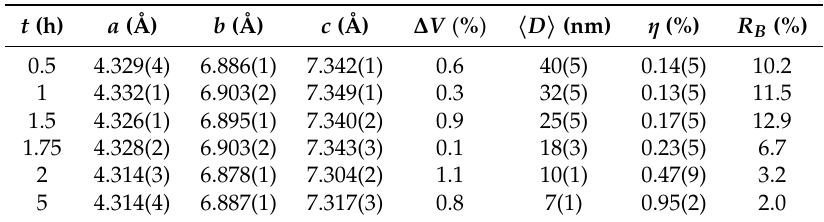
Table 1. Orthorhombic mean lattice parameters ( a , b and c ); relative change in the unit size volume cell with respect to the unit cell in bulk alloy ( ∆ V ), size (cid:104) D (cid:105) , microstrain η and Bragg factor R B of nanoparticles at different milling times ( t ). Bragg factors (R B ) close to 10% ensure the reliability of our refinements.